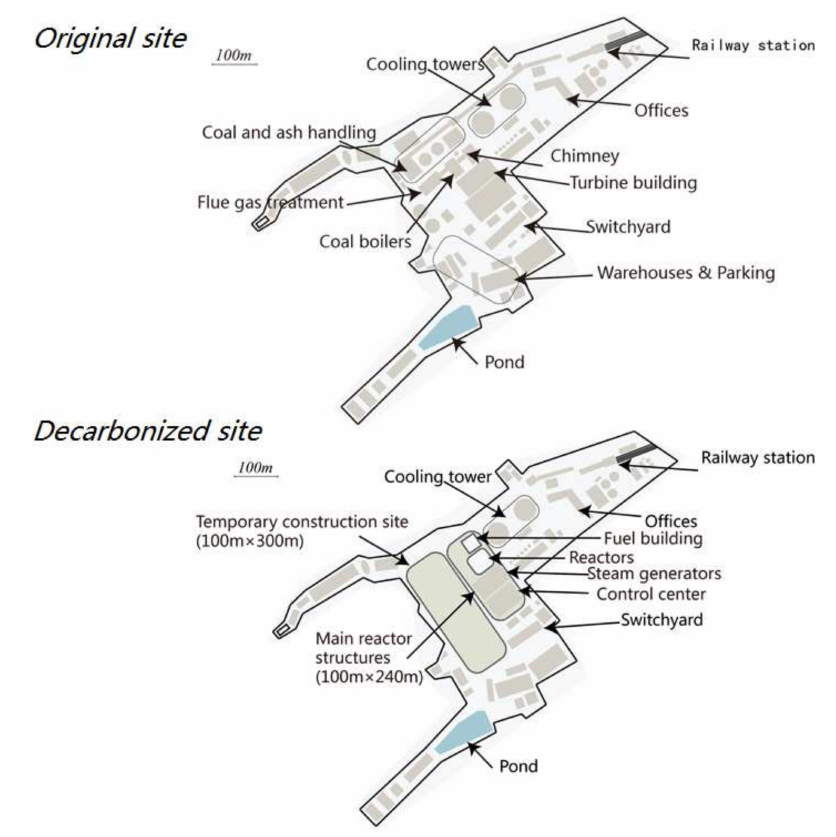
Figure A7. Retrofit decarbonization of Taishan with nuclear